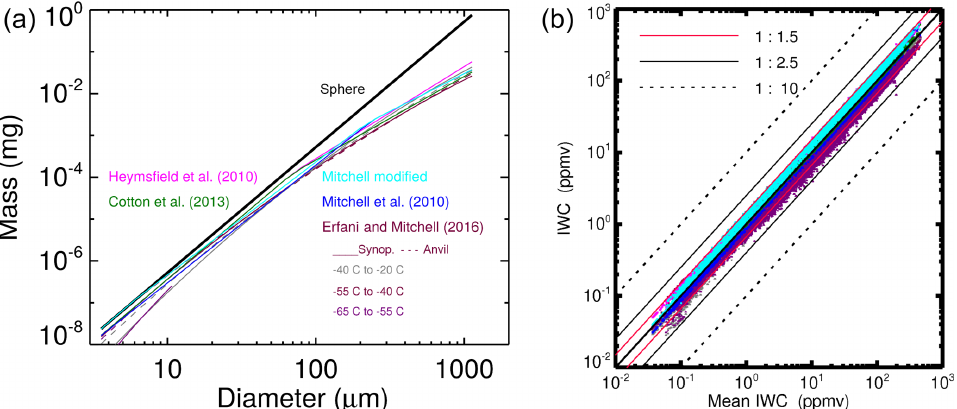
Figure 8. (a) Ice particle mass in relation to size: summary of mass-dimension ( m – D ) relations. The black line is for an ice sphere. (b) IWCs calculated from the different m – D relations vs. their mean IWC for one flight during ML-CIRRUS (29 March 2014) where the entire IWC range is covered by the measurements. 55% of the data are between 1: ± 1.2, while 19/26% can be found in the ranges 1: − (1.2 to 1.5)/1:(1.2–1.5).